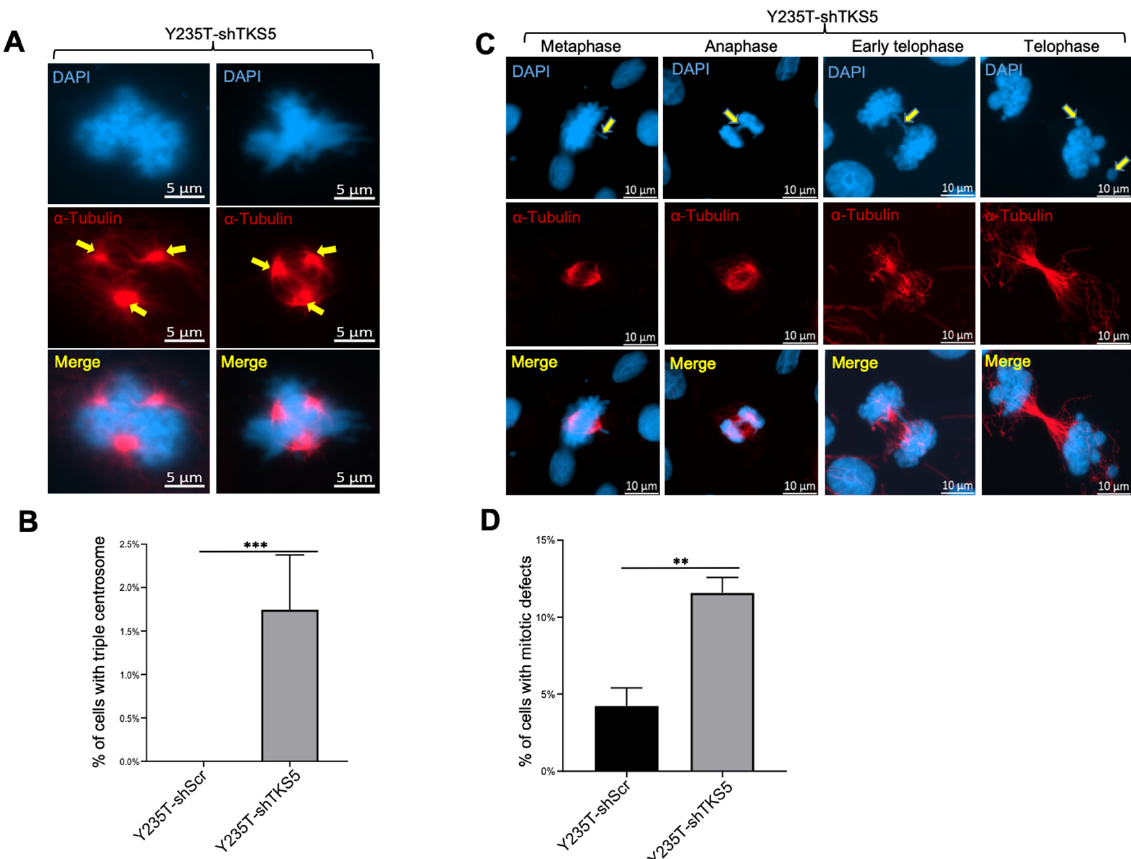
Figure 5. TKS5 knockdown in Y235T cells resulted in mitotic defects. ( A ) Two representative sets of pictures representing the phenomenon of multiple centrosomes. Yellow arrows indicate triple centrosomes. ( B ) We observed an abnormal number of multiple centrosomes in 1.7% of mitotic cells, whereas none of the control cells had these structures. ( C ) Representative pictures from three independent experiments depicting chromosome segregation defects in metaphase, anaphase and telophase during mitosis. Yellow arrowhead in ( C ) indicates chromosome misalignment. ( D ) Percentage of mitotic defects during mitosis in control cells and TKS5-knockdown cells. We took the pictures with a 63× objective lens. We used Student’s t -test and the F-test to analyse the statistical significance (Figure 4B,D, respectively). Error bars represent mean +/ − SEM (** p < 0.01; *** p < 0.001).